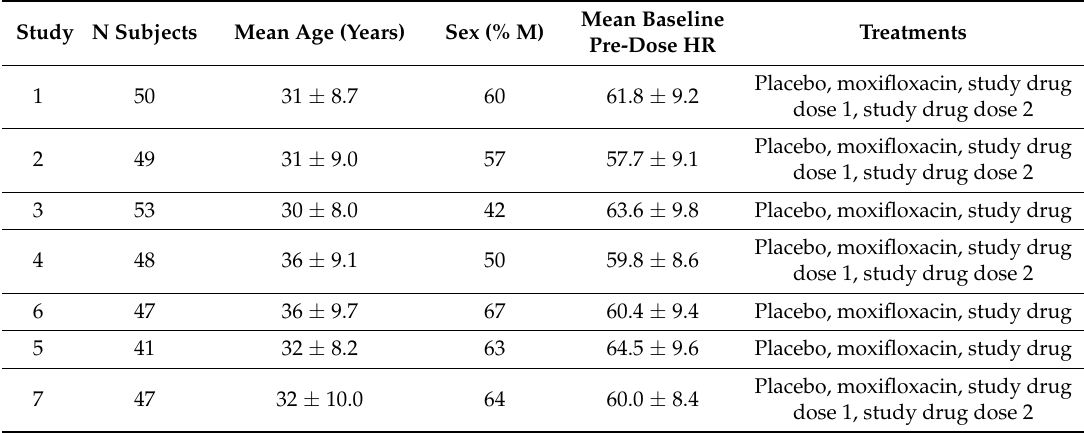
Table 1. Description of the seven clinical studies.